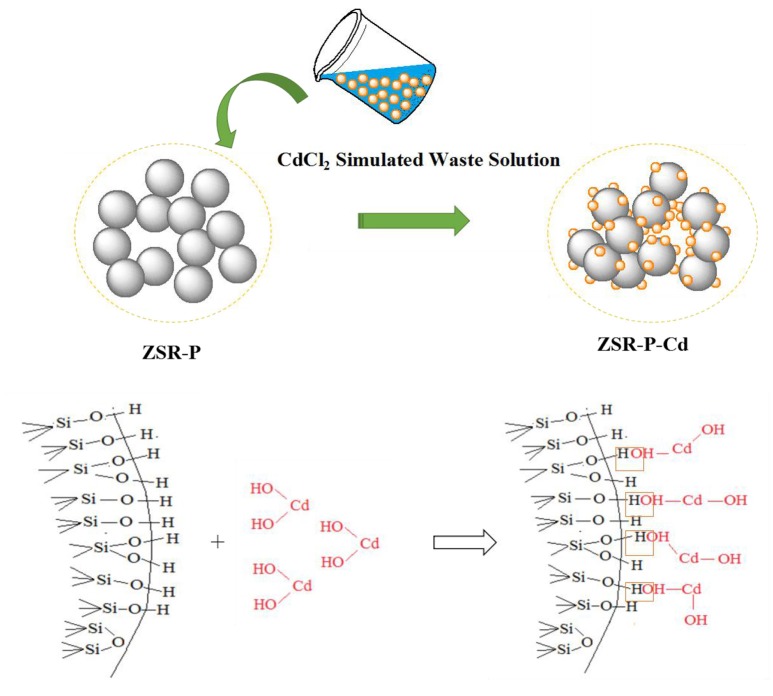
ZSR-P adsorption model of Cd2+.